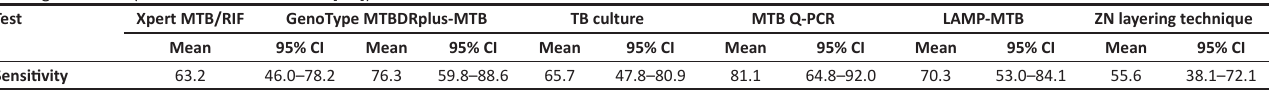
TABLE 2: Sensitivity testing: Excluding test of interest and one of the remaining five tests positive as the gold standard with prevalence (pretest odds) of tuberculous meningitis at 65 % (95 % confidence intervals [CIs]). Test Xpert MTB/RIF GenoType